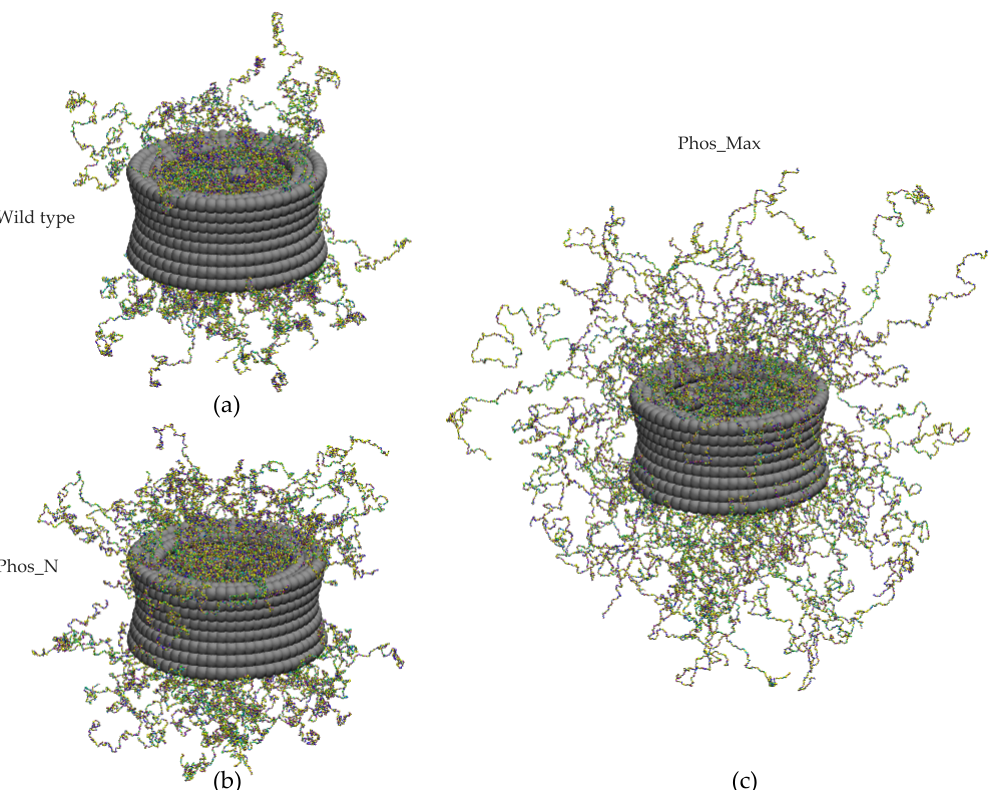
Figure 3. Snapshots of the coarse-grained MD models of ( a ) the wild type NPC, ( b ) the Phos_N NPC, and ( c ) the Phos_Max NPC. The FG-Nups (different color beads denote different amino acids) are attached at the same anchor positions, as in [35,48]. Phosphorylation-induced changes in the interaction leads to spilling of FG-Nups out of the